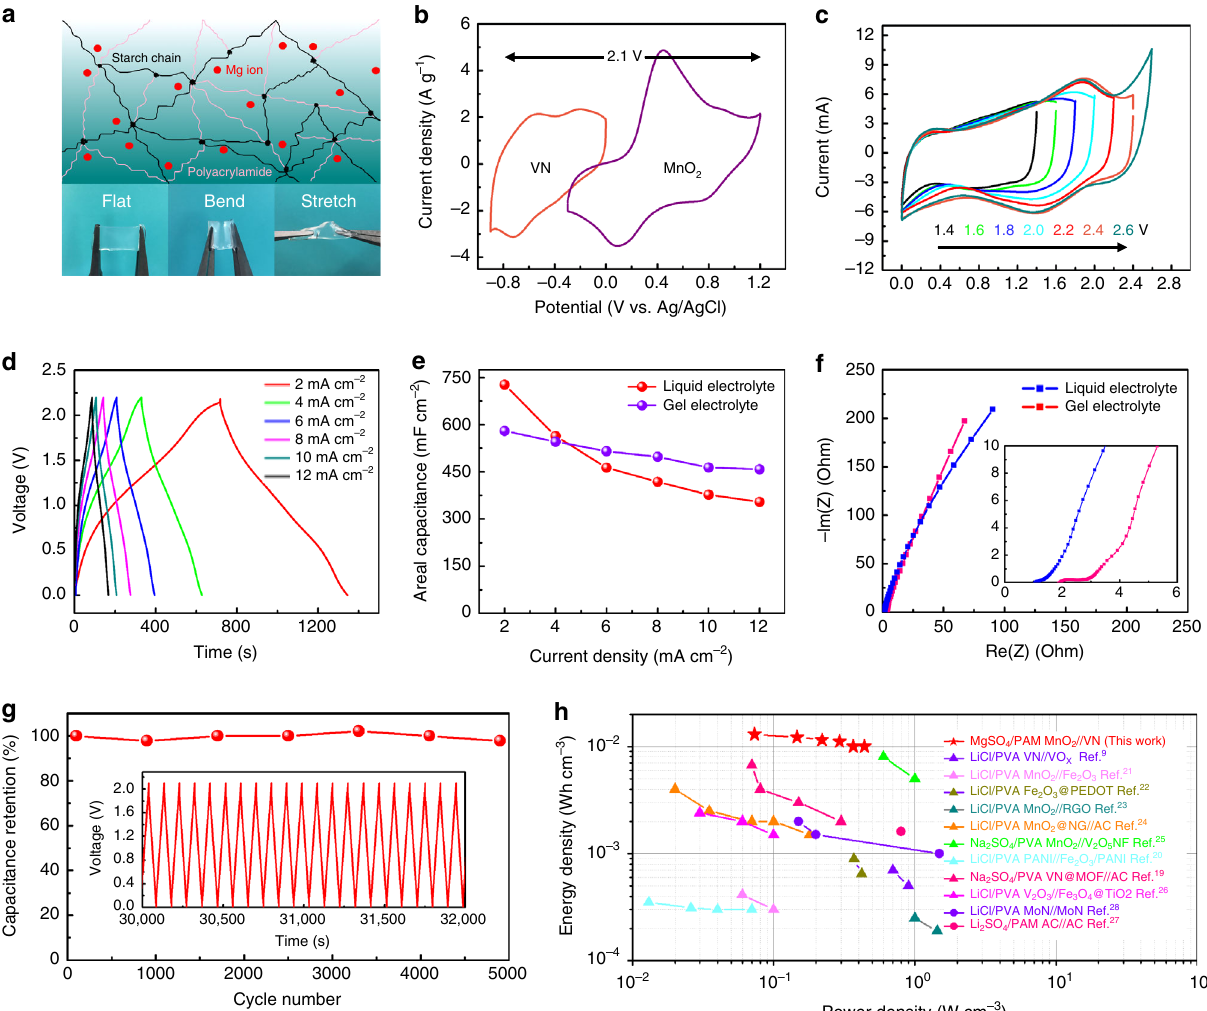
Fig. 4 Electrochemical performance of Mg ion quasi-solid-state ASCs. a Structural diagram of a PAM gel electrolyte and digital photos showing its mechanical robustness upon deformation. b CV curve obtained for the VN and MnO 2 electrodes, respectively, at different potential ranges at a scan rate of 10 mV s − 1 . c CV curves of a quasi-solid-state ASC with an increasing voltage window from 1.4 to 2.6 V at 10 mV s − 1 . d Galvanostatic charge/discharge curves of ASCs under different current densities. e Comparison of areal speci fi c capacitance of a liquid electrolyte and a gel electrolyte under different current densities. f Nyquist plot of a liquid electrolyte/separator and a gel electrolyte. g Long-term cycling stability of a quasi-solid-state ASC at a charge/ discharge current density of 16 mA cm − 2 . h Ragone plot of our quasi-solid-state ASC devices in comparison with other recently reported